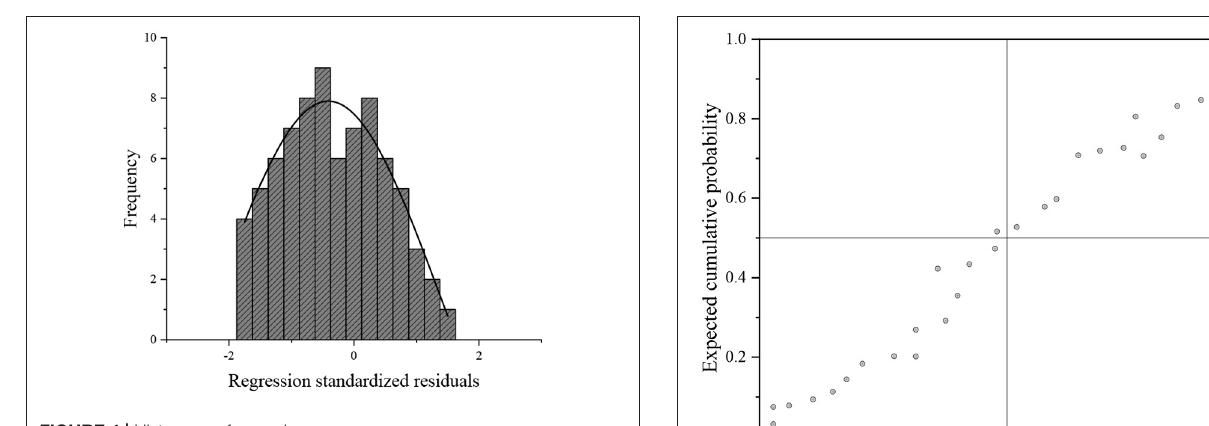
FIGURE 4 | Histogram of normal curve.